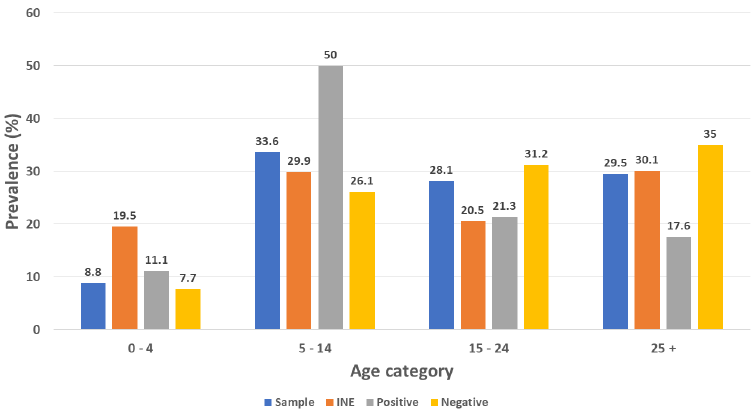
Figure 4. Malaria prevalence by age group in Sussundenga Village, INE = National Institute of Statistics.